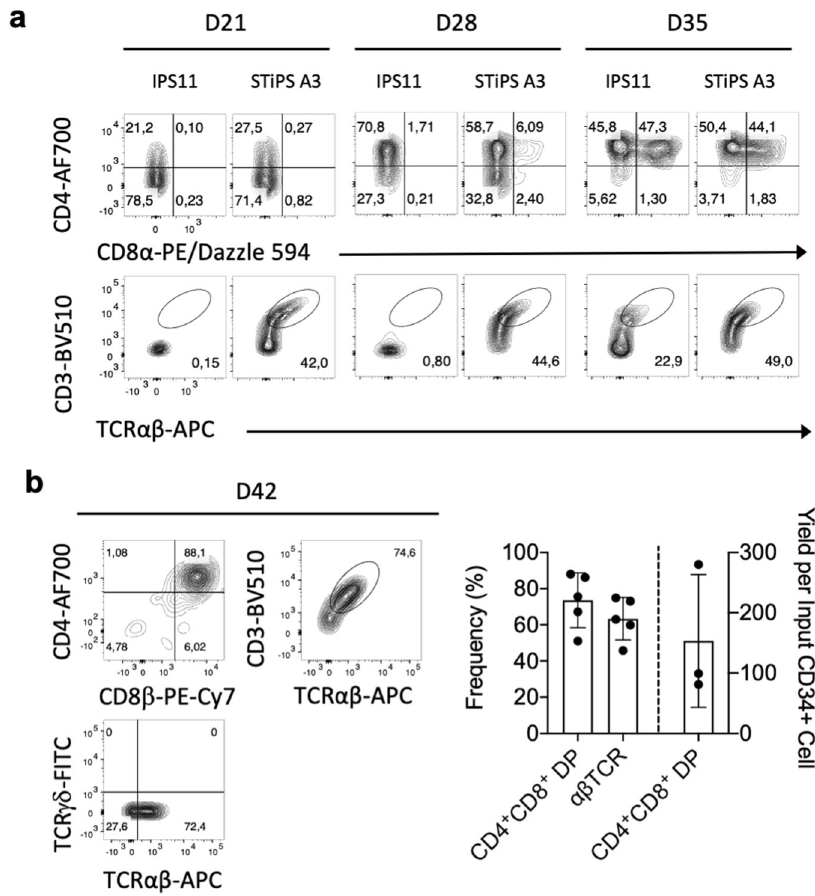
Fig. 4 Generation of PSC-derived CD3 + αβ T cells. a Representative fl ow cytometry plots of human IPS11- and STIPS.A3-derived CD34 + cells cultured for up to 35 days with DL4- µ beads. Cells were harvested, counted and analyzed by fl ow cytometry for the surface expression of CD4, CD8, TCR αβ and CD3, as indicated. b D42 IPS11-derived T-lineage cells were harvested and stained for the expression of CD4, CD8 β , TCR αβ , TCR γδ and CD3, as indicated. Frequency of CD4 + CD8 + DP cells and αβΤ CR-expressing cells are plotted, and total cell expansion was normalized to input day 0 PSC-derived CD34 + cells after culture with DL4- µ beads for 42 days ( n = 3). Data represent means± s.d. of n independent experiments. All data gated on DAPI − CD45 + cells. IPS11 = iPSC line derived from fi broblasts; STiPS A3 = iPSC line derived from T